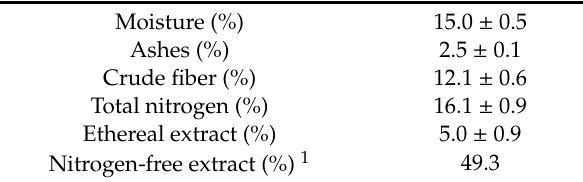
Table 1. Chemical proximate analysis of non-treated vetch